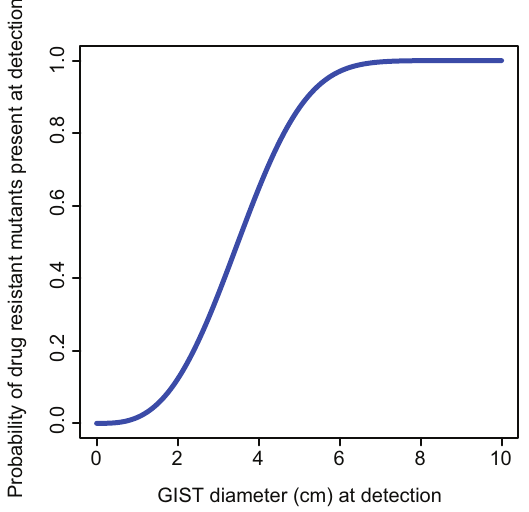
Figure 1. The estimated lower bound for the probability that mutant cells resistant to imatinib are already present in a gastrointestinal stromal tumor (GIST) at time of treatment, as a function of tumor